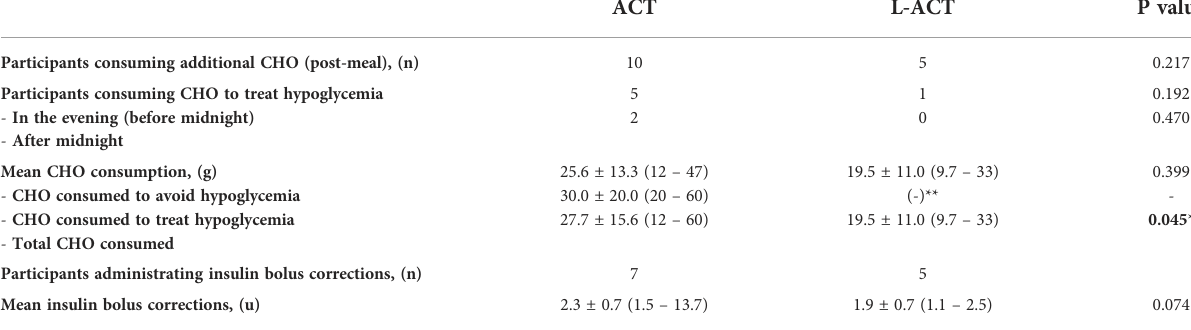
TABLE 5 Reported additional CHO and insulin bolus intakes during the